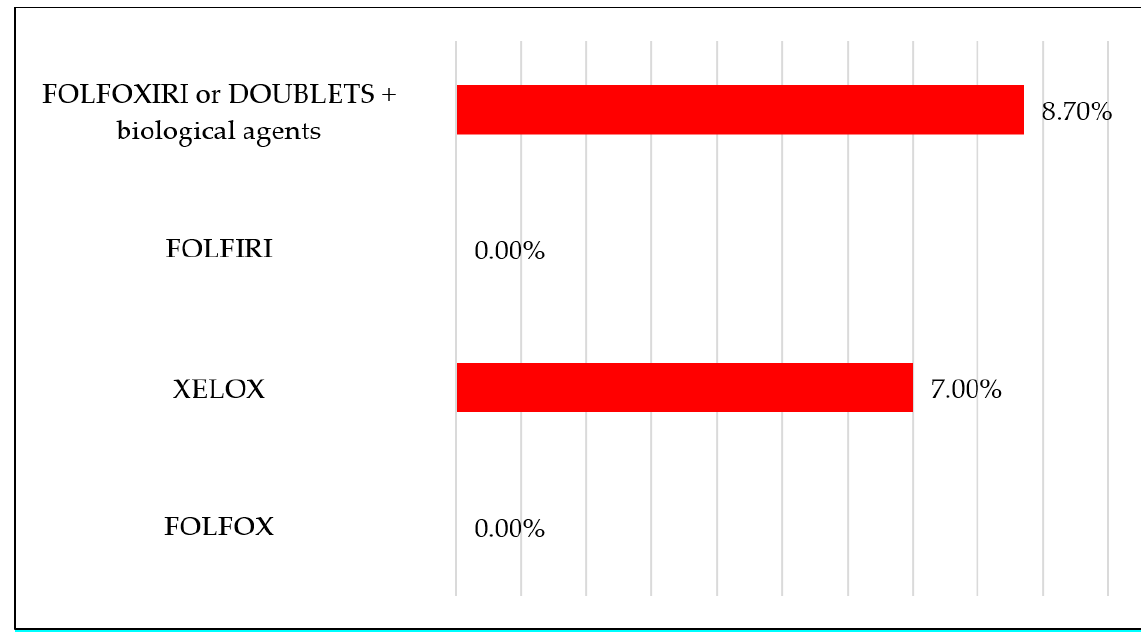
Figure 3. Percentage of observed G3–4 diarrhoea for various treatments.